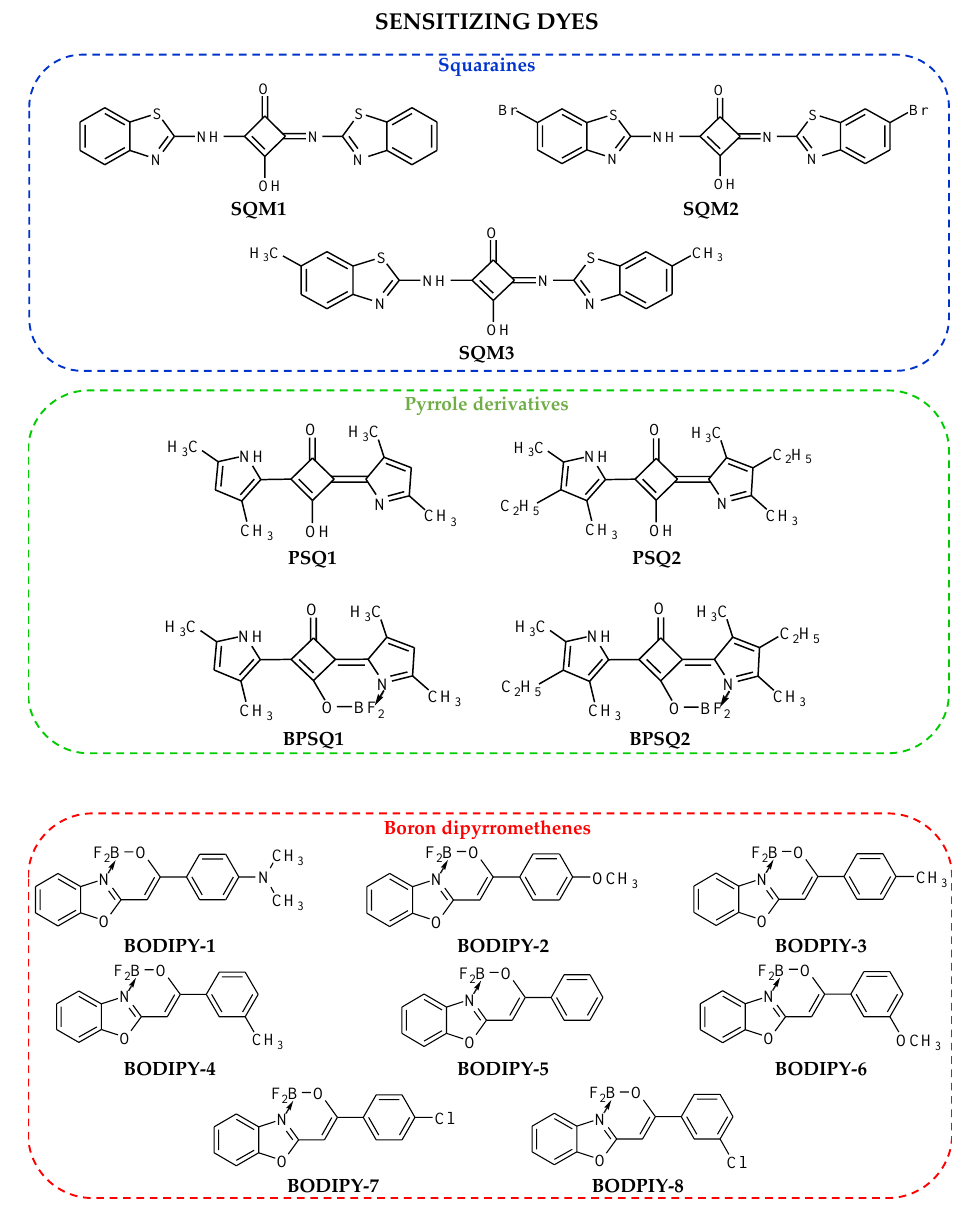
Figure 11. Chemical structures of sensitizers.